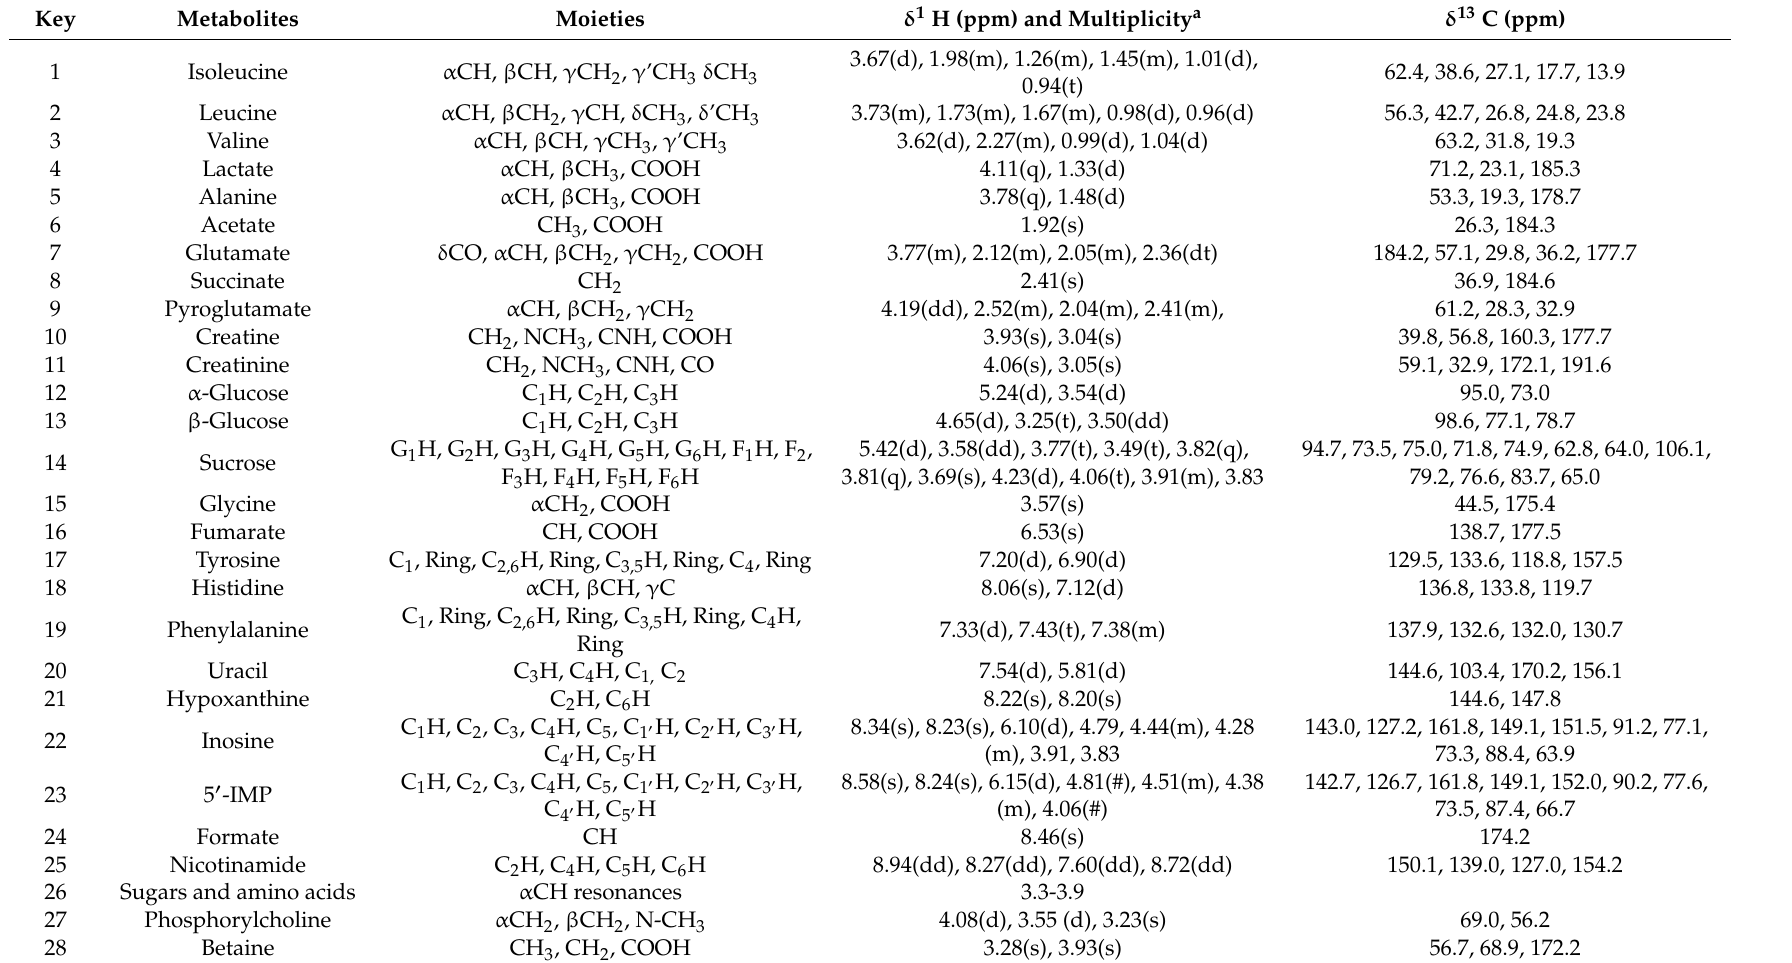
Table 1. NMR data of taste-active